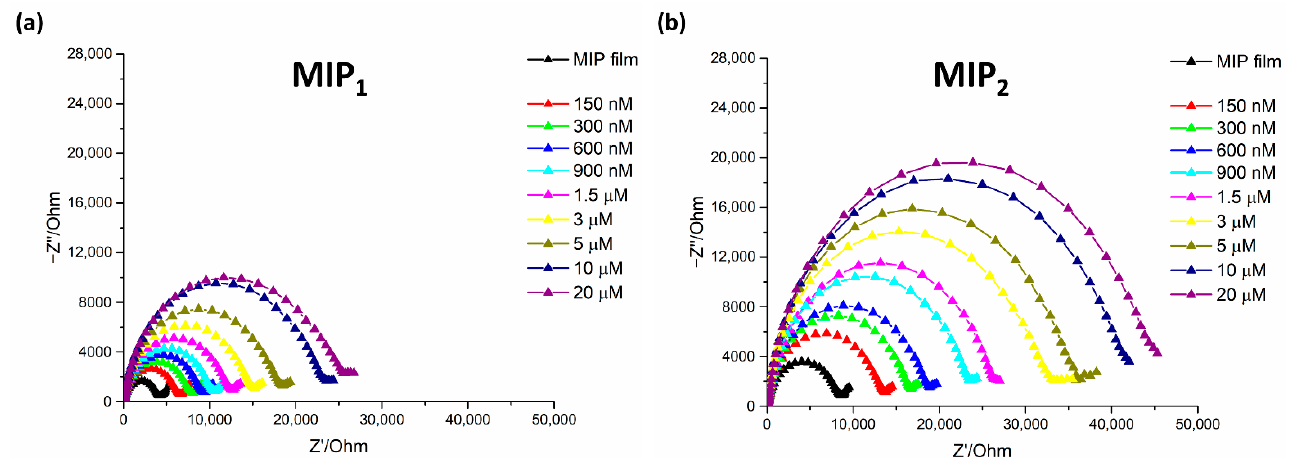
Figure 4. Nyquist impedance plot in 5 mM of [Fe(CN) 6 ] 3 − / 4 − for Lyz detection at different concentration on ( a ) MIP 1 and ( b ) MIP 2 sensors. Frequency range: from 0.1 Hz to 10 kHz. AC potential: 5 mV and DC potential: 0.18 V.